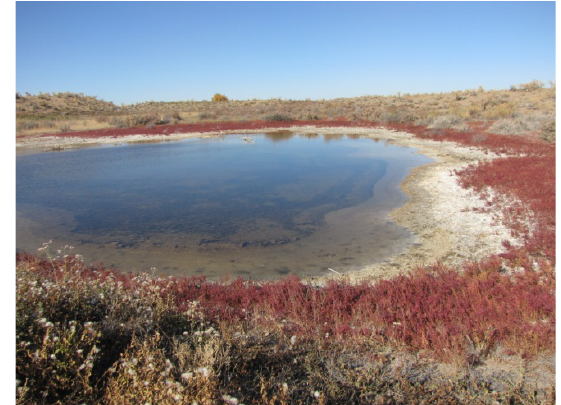
Figure 1C. The unusual ecosystem of Southern Kazakhstan. In Southern Kazakhstan (Almaty region), samples were collected from the soils of the arid zone, typical meadows and sor solonchaks, salinized takyrs, takyr-like salinized soils, and rhizospheres of the arid zone